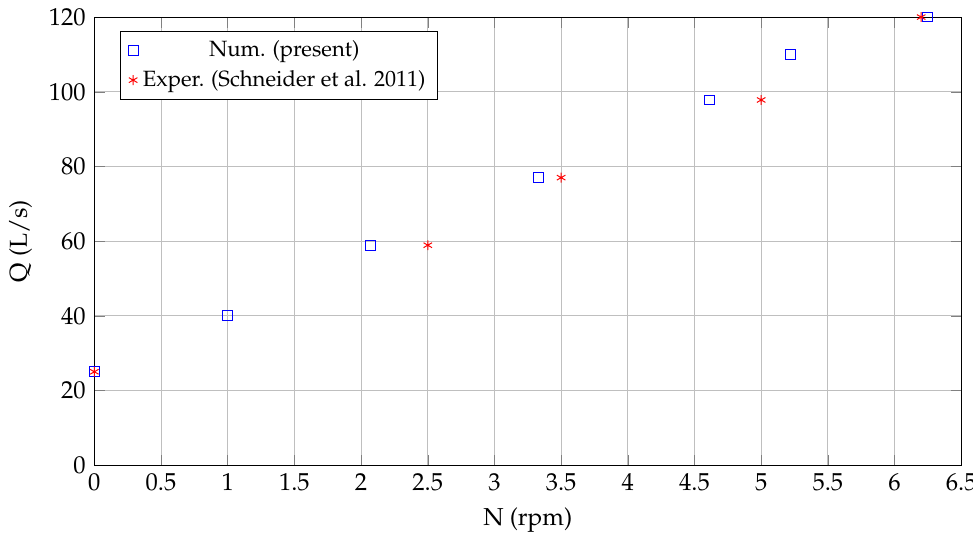
Figure 16. Relationship between discharge and rotating speed of the HPM. Comparisson of numerical with experimental results presented in Schneider et al. (2011) [38].